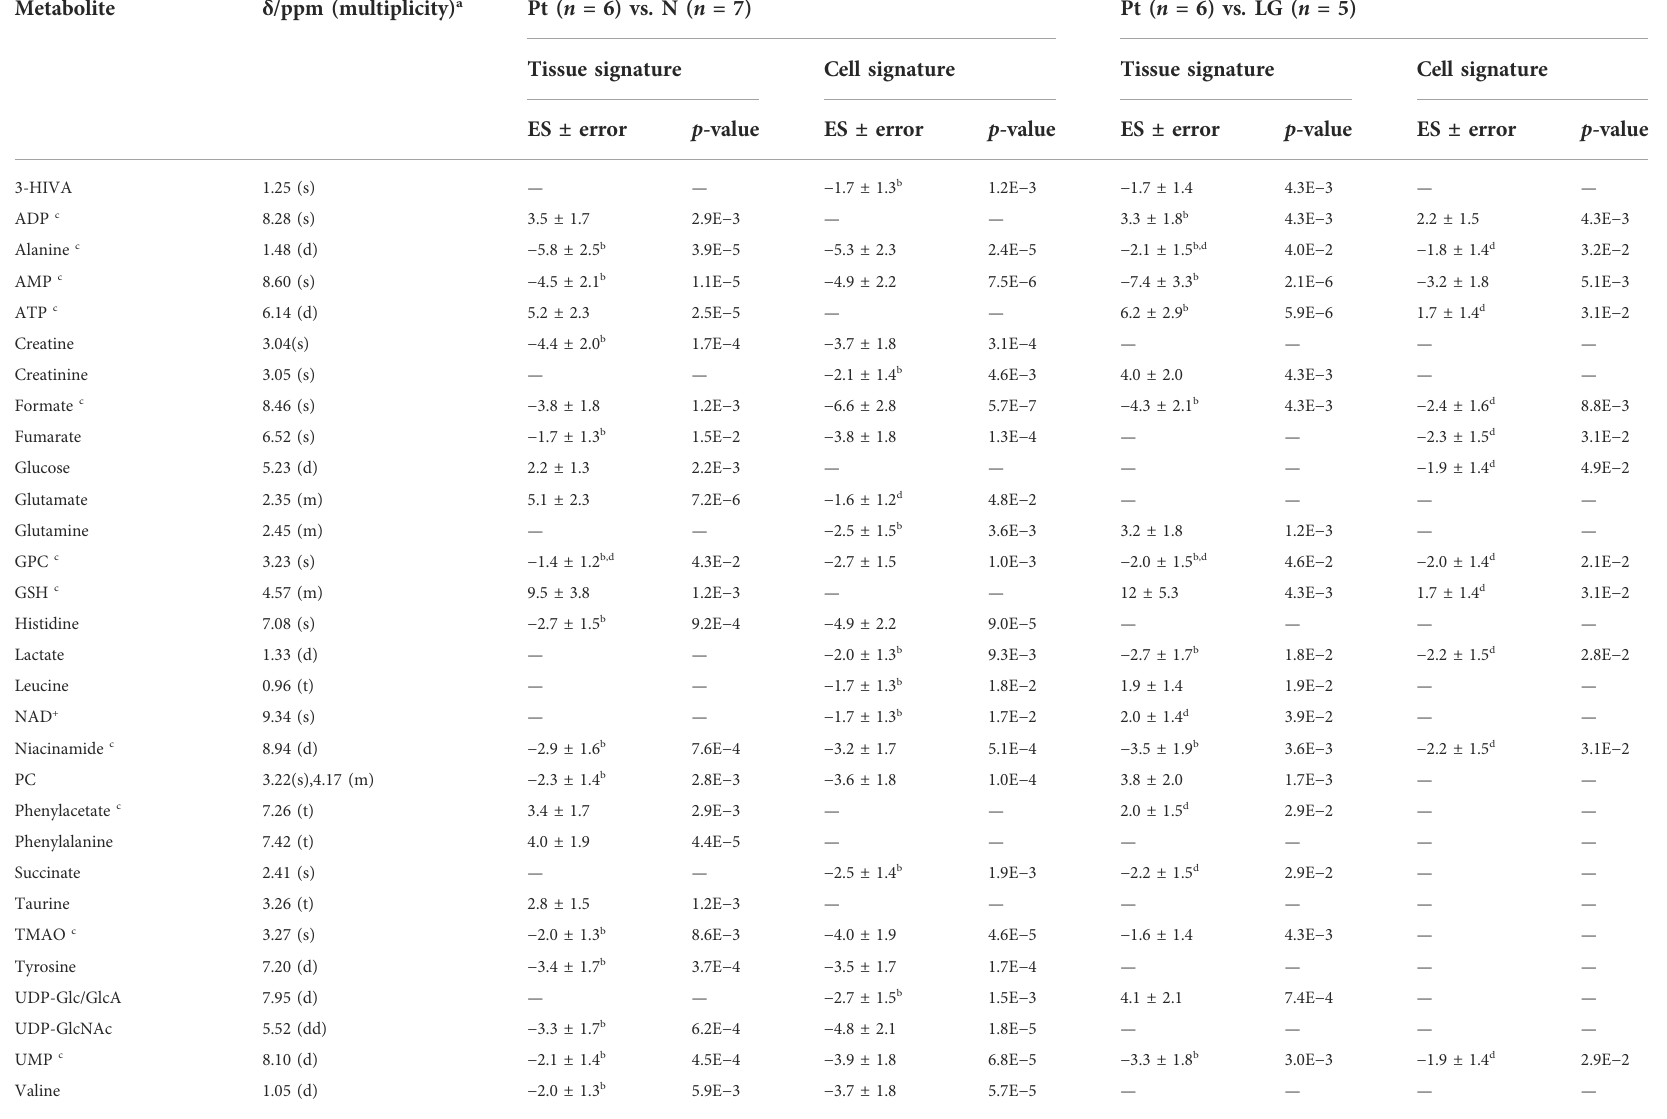
TABLE 2 Polar pancreatic metabolites varying between pancreatitis induced-mice (Pt) and normal tissue (N) (left), and between Pt and LG PanIN lesions (LG)